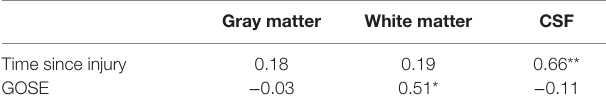
TaBle 5 | Pearson product-moment correlations of brain volume with time since injury and functional outcome. gray matter White matter csF Time since injury 0.18 0.19 0.66** GOSE − 0.03 0.51* − 0.11 CSF, cerebrospinal fluid; GOSE, Glasgow Outcome Scale-Extended. n = 16. The data of one participant with outlier CSF values were excluded from this analysis. *Significant at the 0.05 level (two-tailed). **Significant at the 0.01 level